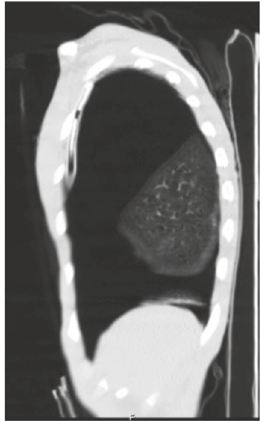
Figure 5: Chest CT scan sagittal cuts showing the chest tube